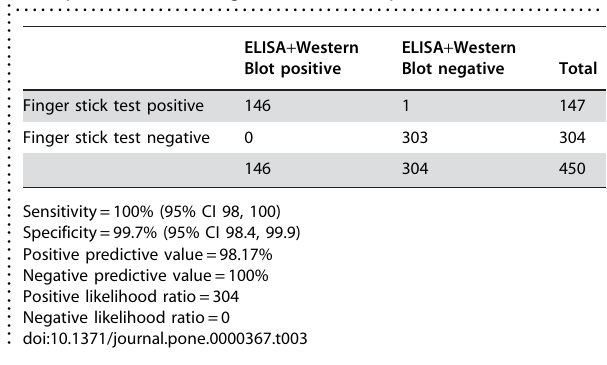
Table 3. Diagnostic accuracy of the OraQuick HIV-1/2